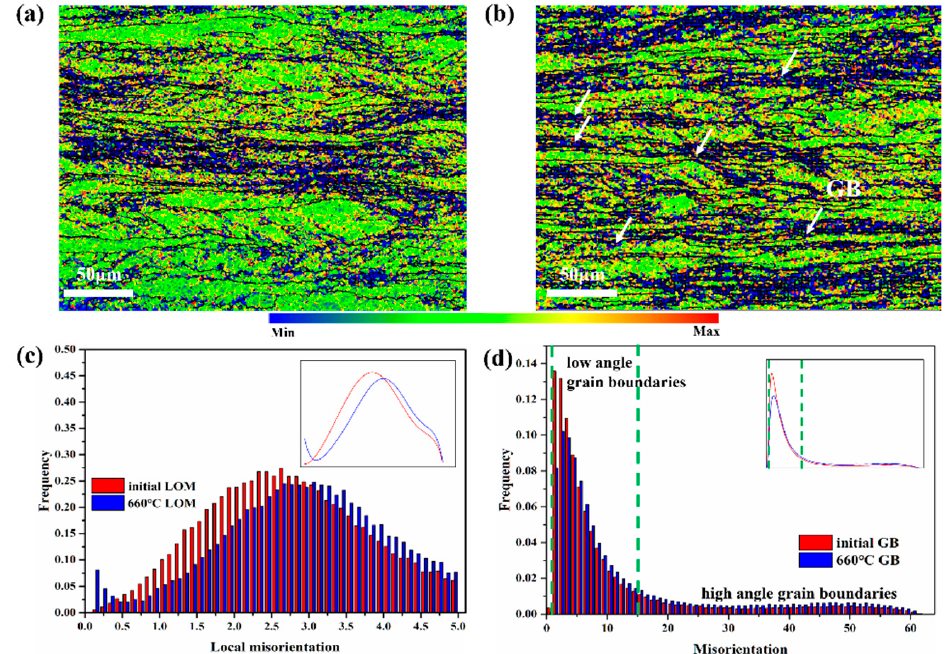
Figure 6. Local misorientation and grain boundaries at the initial and recovery stages: ( a ) distribution of local misorientation at the initial stage, ( b ) distribution of local misorientation at the recovery stage, ( c ) average local misorientation and ( d ) grain boundaries.